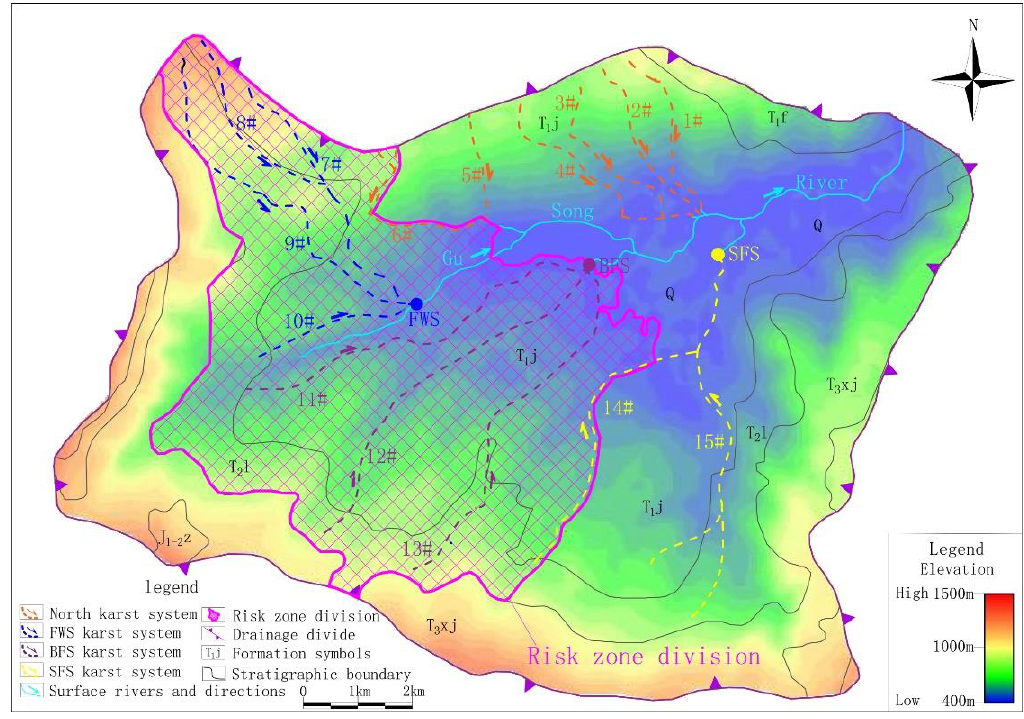
Figure 10. Results of risk zone designation.